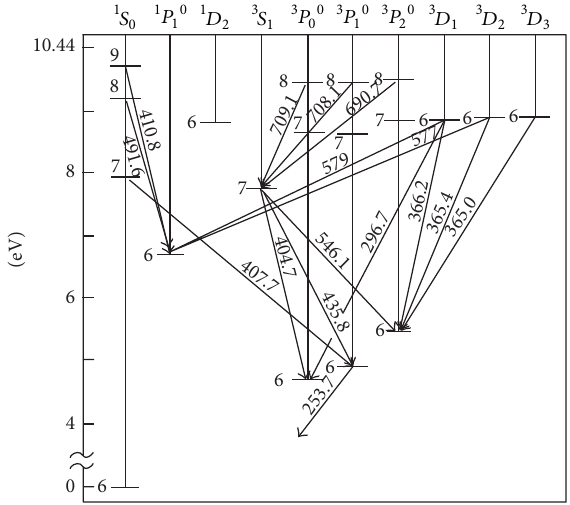
Figure 2: Scheme of the mercury atom levels. Wavelengths in nm are specified for the lines observed in spectrum of the 3 He-Hg mixture, excited by 𝛼 -particles. Lines in the area of 313 nm are not